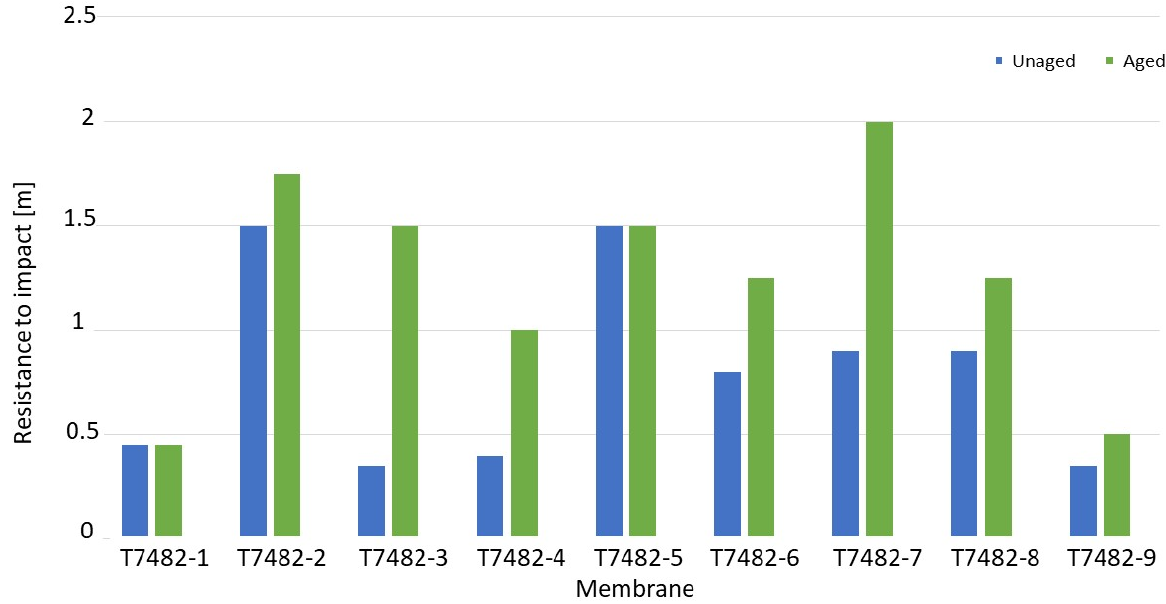
Figure 17. Resistance to impact for unaged and aged samples of membranes.